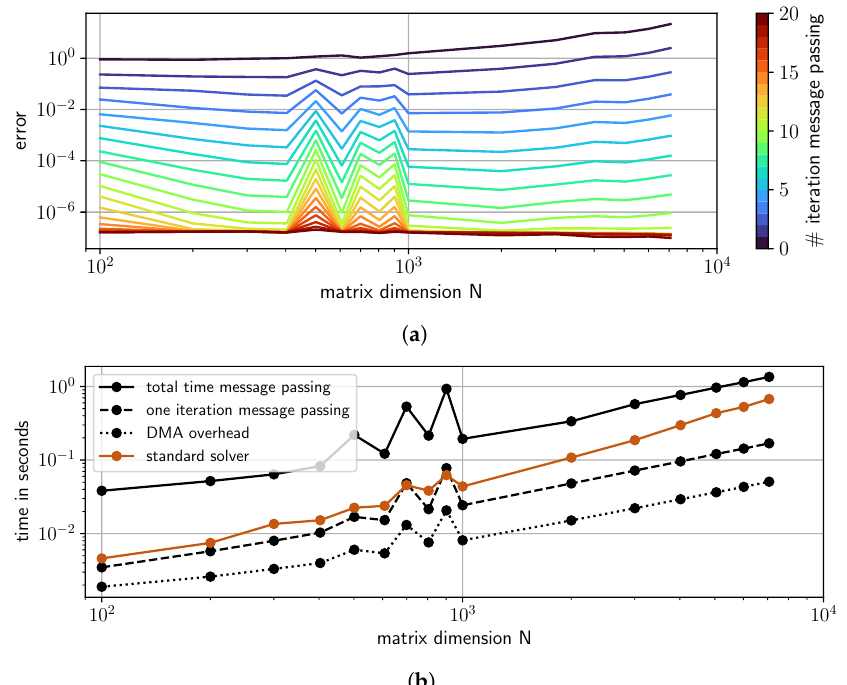
Figure 13. The plots show the same results as Figure 12. However, this time for the PYNQ-Z1 board. Due to less memory, only LESs with dimension N less than 8000 are evaluated. The plots in ( a ) illustrate the convergence, where ( b ) shows the required computation